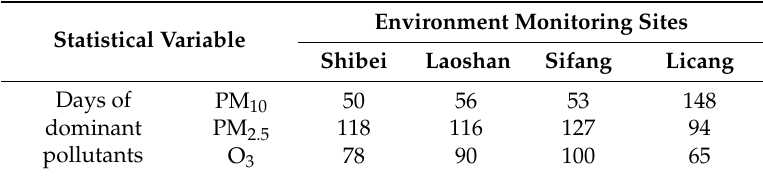
Table 4. Statistical characteristics of AQI and days of dominant air pollutants at the four sites.